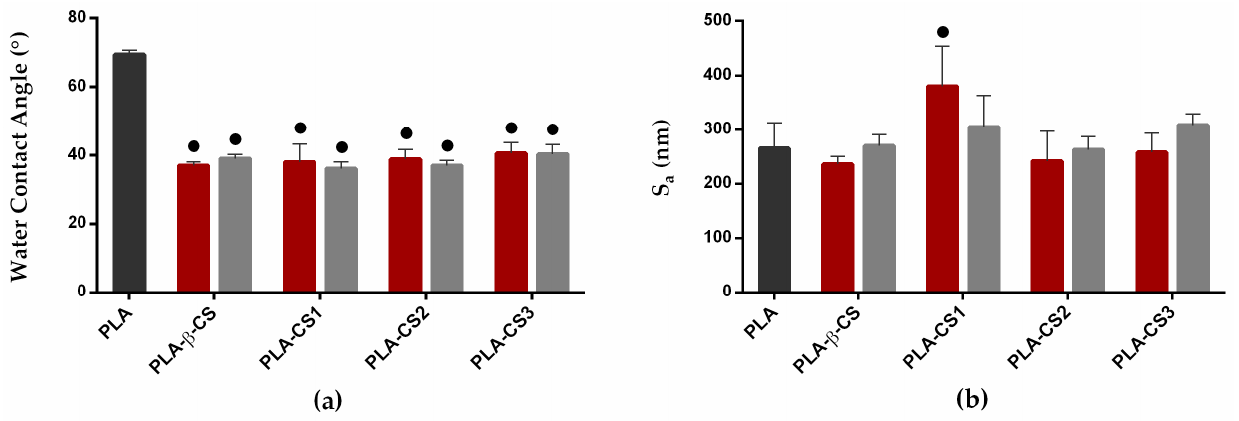
Figure 2. Water contact angles ( a ) and average roughness ( b ) values for the ■ PLA film, ■ 0.5% and ■ 1% PLA-CS surfaces (PLA, PLA- β -CS, PLA-CS1, PLA-CS2, and PLA-CS3). The means ± standard deviations are illustrated. Differences between PLA and the functionalized surfaces were evaluated using the non-parametric Mann–Whitney test and represented for p -values < 0.05 by ● .